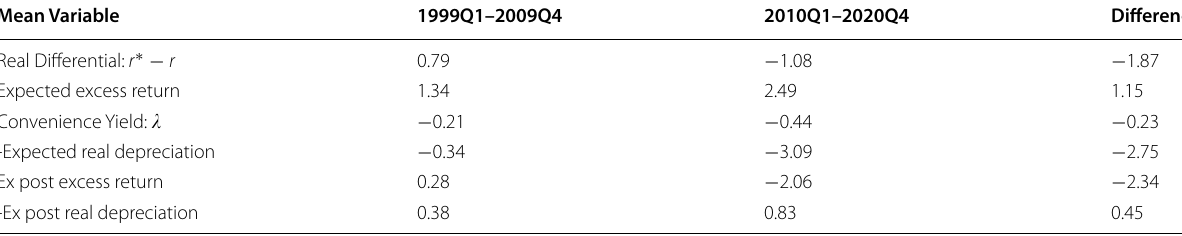
This decomposition is based on Eq. (3), according to which: real yield differential = expected excess return + convenience yield data come from Datastream and Consensus Economics. All figures are expressed in percentage points